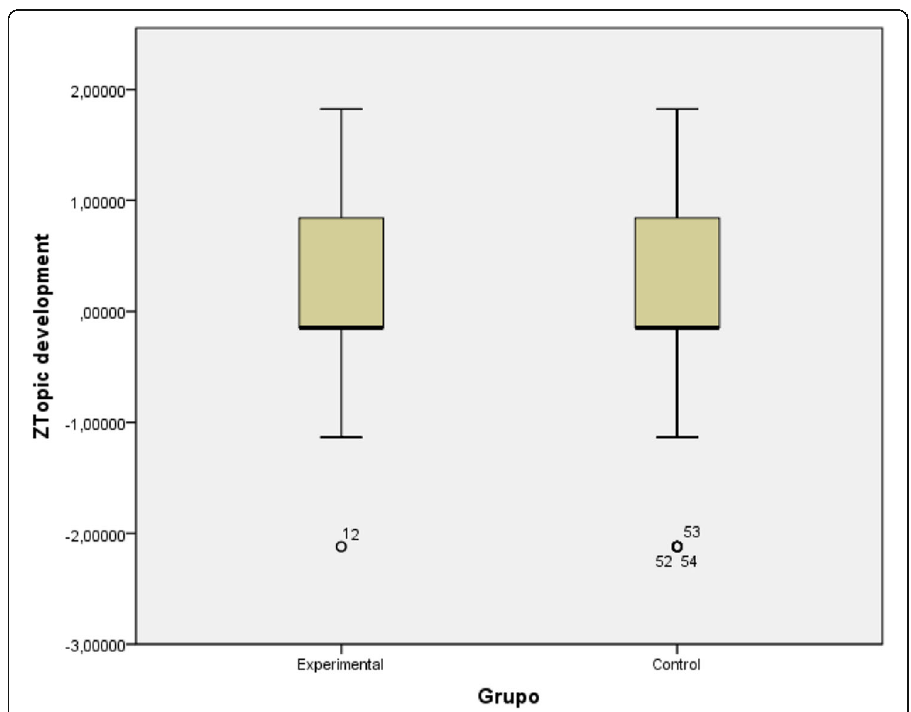
Fig. 2 Box-and-whisker plot in topic development by students in both, experimental and control groups